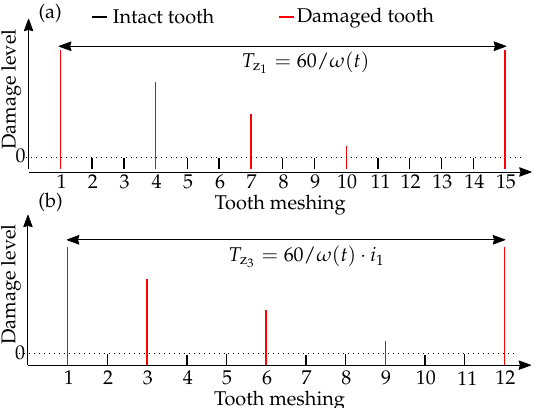
Figure 4. Theoretical occurrence of tooth meshing of damaged teeth for gear z 1 in ( a ) and z 3 in ( b ).